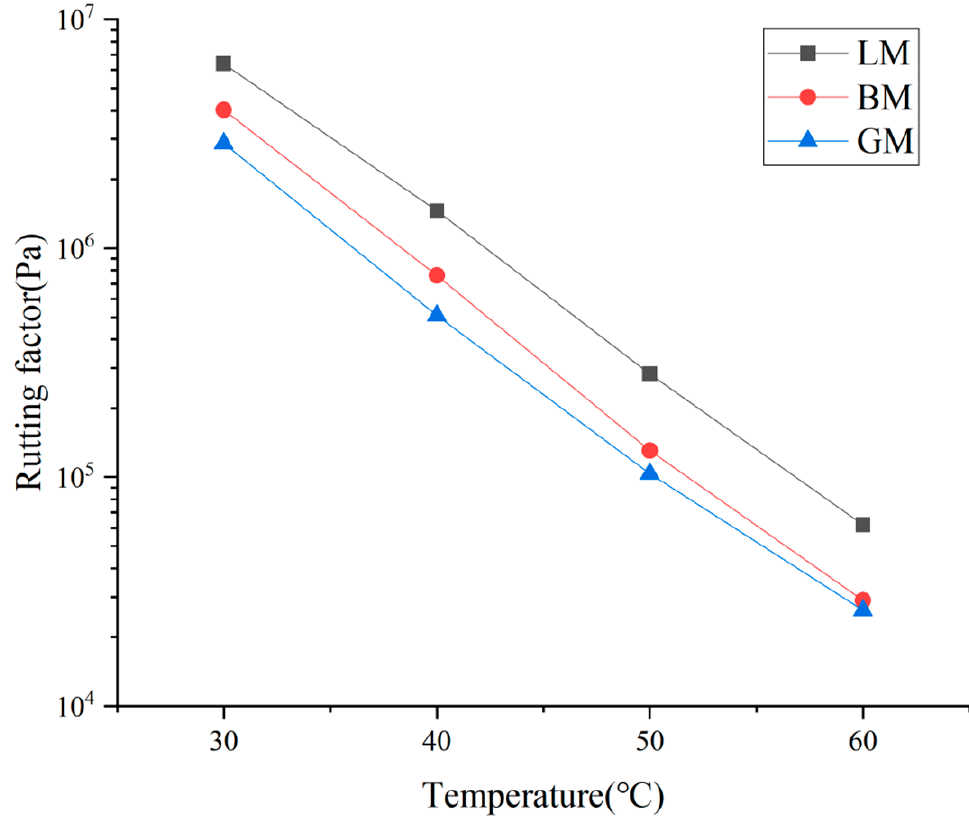
Figure 7. Rutting factors of asphalt mastics.